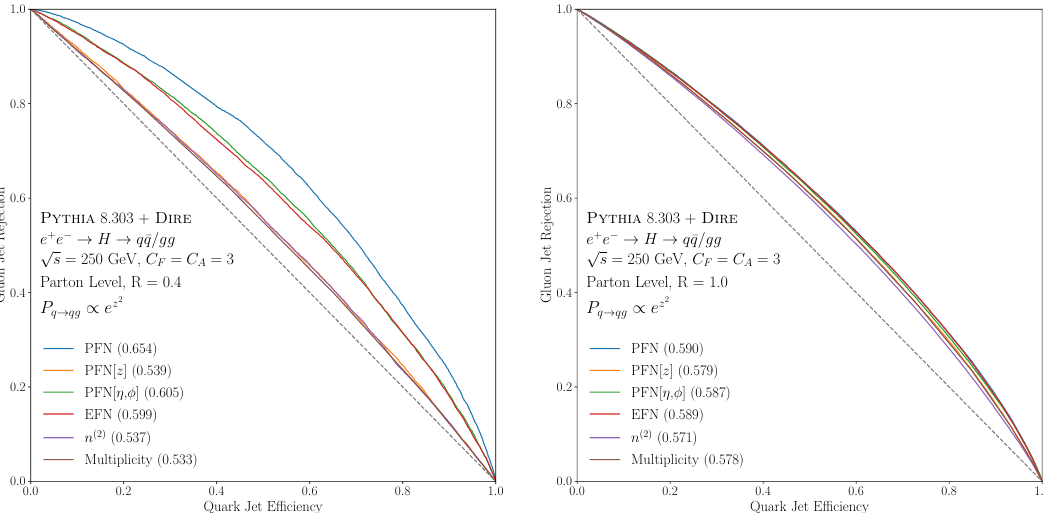
Figure 3 . ROC curves and AUC scores (listed in the legend) for the likelihood ratio observable n (2) , multiplicity, and the four benchmark DNNs with settings C F = C A = 3 and P q → qg ∝ exp( z 2 ) . In the R = 0 . 4 case (left), classifiers that use angular information appear to outperform those using only momenta. This effect mostly vanishes at R = 1 . 0 , where all perform approximately equally. In both cases, n (2) performs as well as multiplicity.